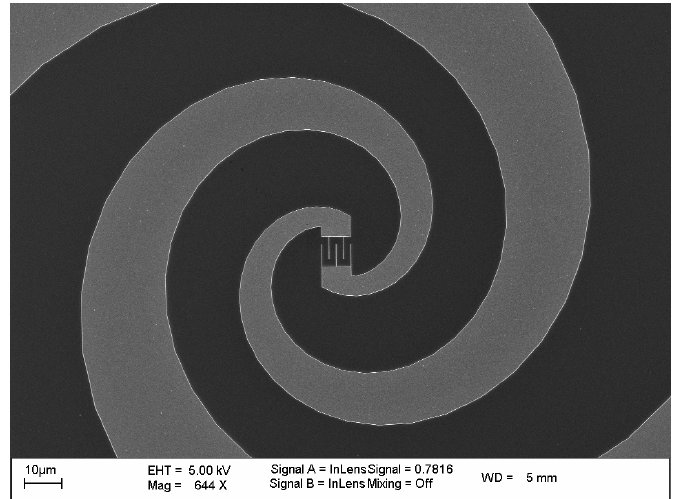
Figure 2 . Scanning electron microscope image of the LTG-GaAs